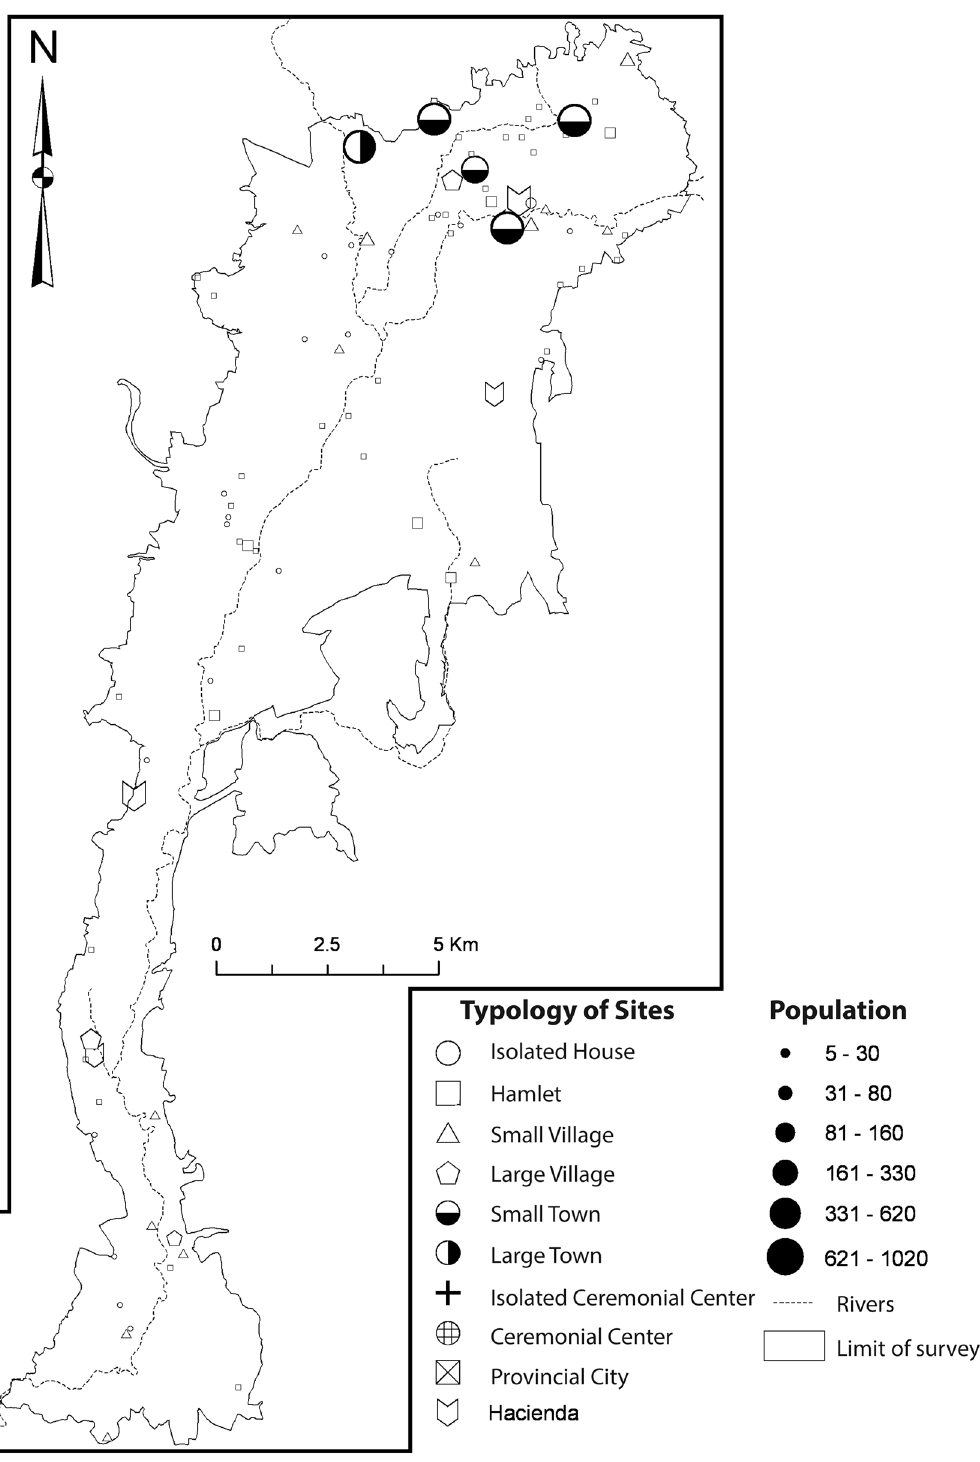
Figure 18: Settlement patterns of the Santiago ( Early Spanish Colonial )